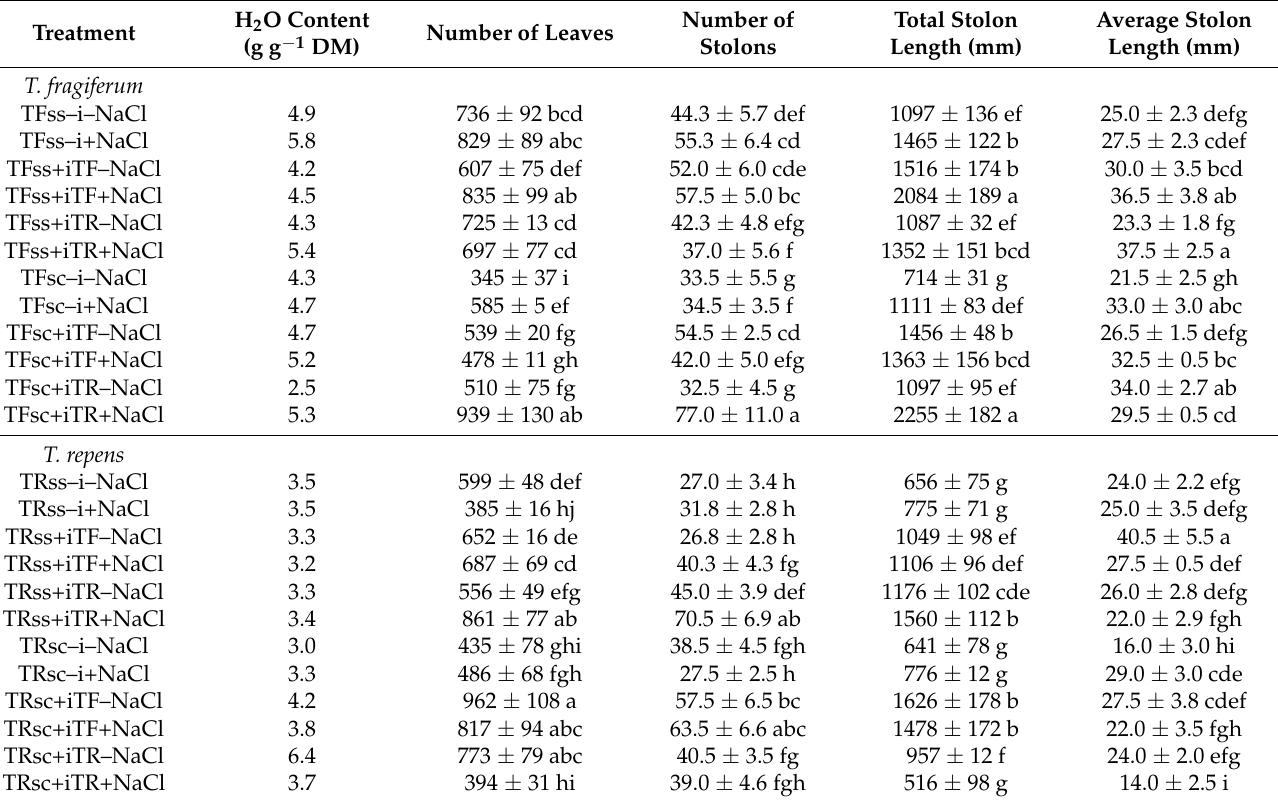
Table 4. Morphological characteristics of T. fragiferum and T. repens plants grown in initially sterile